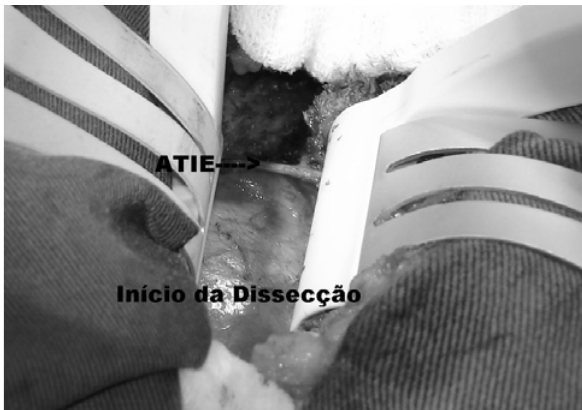
Fig. 1 - Dispositivo afastador para dissecção da ATIE por minitoracotomia